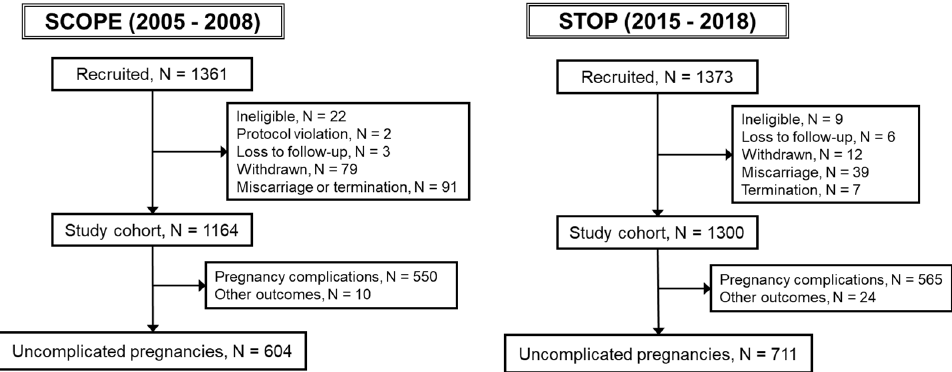
Figure 2. Study flow chart: Study exclusion criteria are shown for both SCOPE and STOP, with final totals of N = 604 and N = 711 participants, respectively, who had uncomplicated pregnancies.